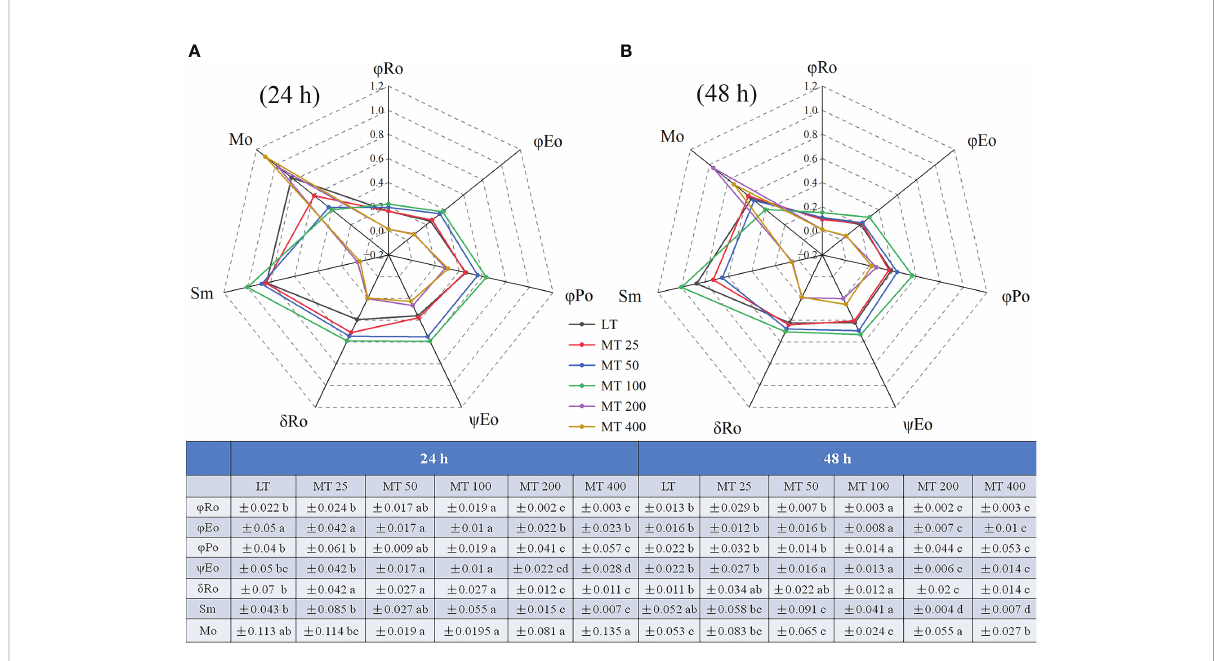
FIGURE 8 Radar plot of the JIP parameters of cucumber leaves under low temperature stress for 24 h (A) and 48 h (B) . The values were represented by the means ± SE. The same letters denoted that there is no signi fi cant difference at P < 0.05 according to Duncan ’ s